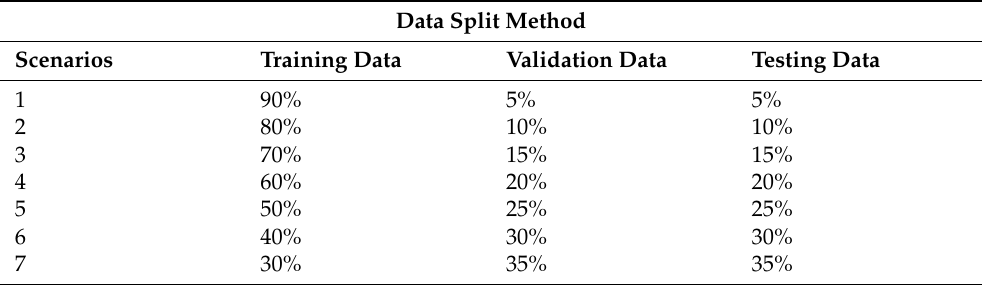
Table 2. Sampling scenarios of the training